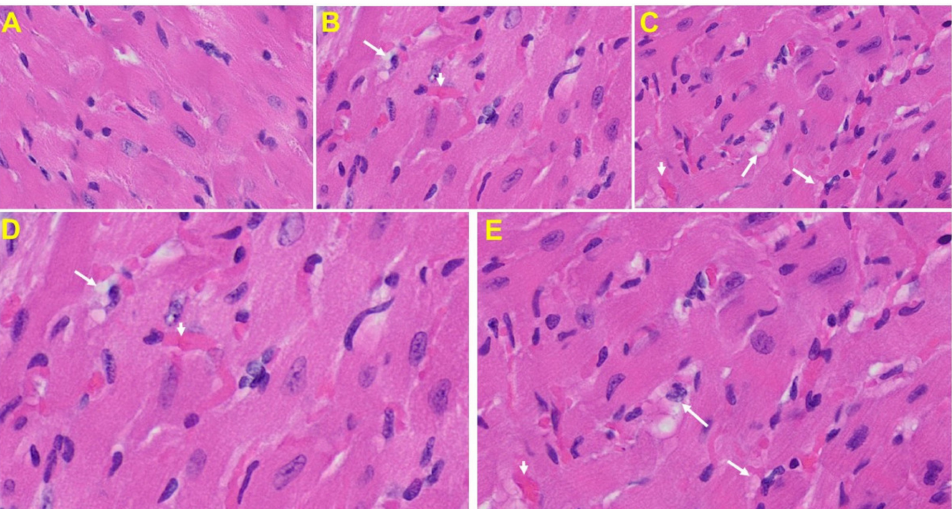
Figure 8. An MHV-1 infected mouse heart. ( A ) Normal mouse heart. ( B , C ) MHV-1 infected mouse heart showing severe interstitial edema (long arrows), vascular congestion and dilation (short arrows), and red blood cell extravasation into the interstitium (enlarged images of an MHV-1 infected mouse heart ( D , E )) (H&E original magnification of A–C is 400 × in A–C as noted in Figure 5B).